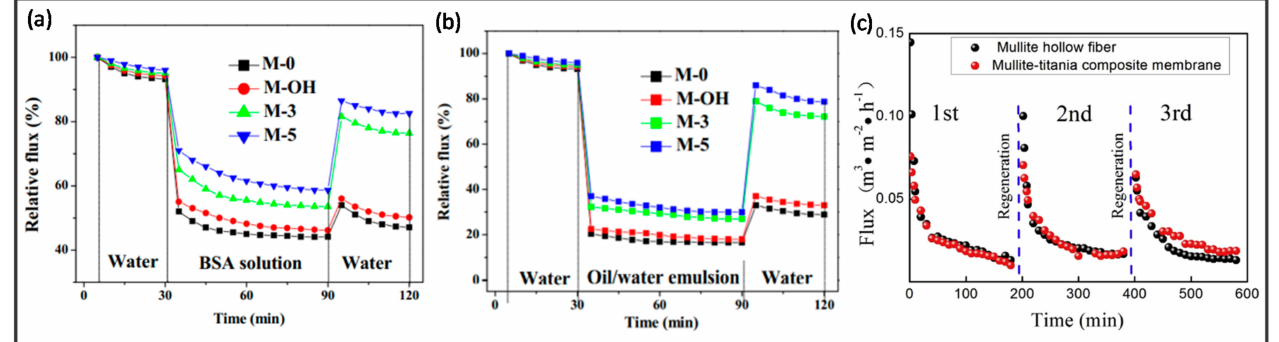
Figure 9. Time − dependent relative flux during filtration of ( a ) BSA solution and ( b ) oil/water emul- sion. Reprinted/adapted with permission from Ref. [214]. Copyright 2016, Elsevier. ( c ) Variation of permeation flux with time during membrane filtration of oil/water emulsion using membrane regen- eration for three cycles via a backflushing of 0.1 wt.% NaOH aqueous solution. Reprinted/adapted with permission from Ref. [216]. Copyright 2016,